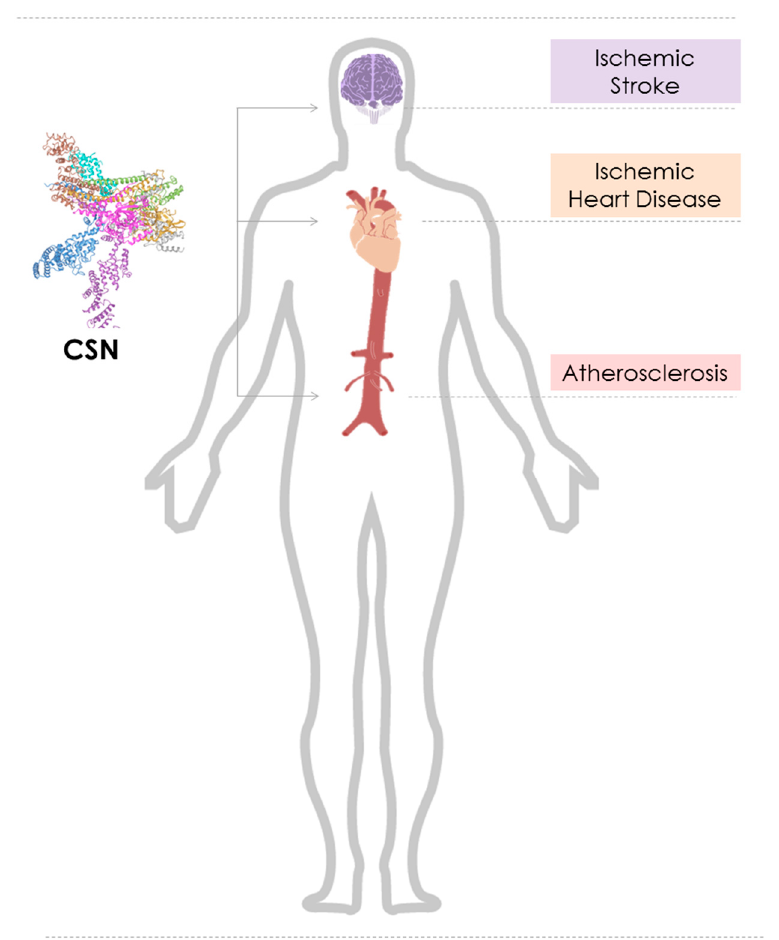
Figure 1. Graphical representation of the role of the constitutive photomorphogenesis 9 (COP9) signalosome (CSN) in cardiovascular diseases. Cartoon illustrating the cardiovascular diseases atherosclerosis, ischemic heart disease, and ischemic stroke, the affected organs/tissues (aorta/vasculature (red), heart (beige/orange), brain (magenta), respectively, and their locations in the human body. The emerging role of the CSN (PDB ID: 4D10) in these diseases is indicated.